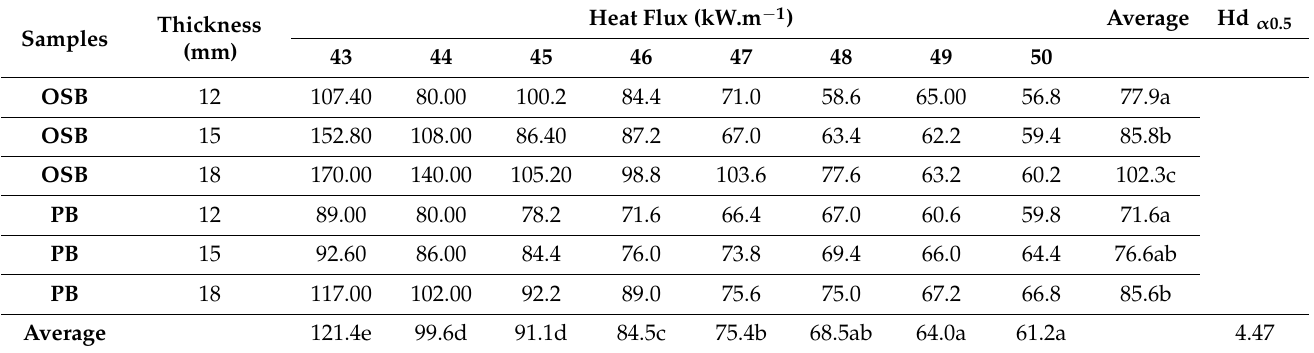
Table 4. The impact of samples (PB, OSB) and impact of thickness (12.15 and 18 mm) on the time-to- ignition through the 1-factor analysis of variance (ANOVA) ( α = 0.05).